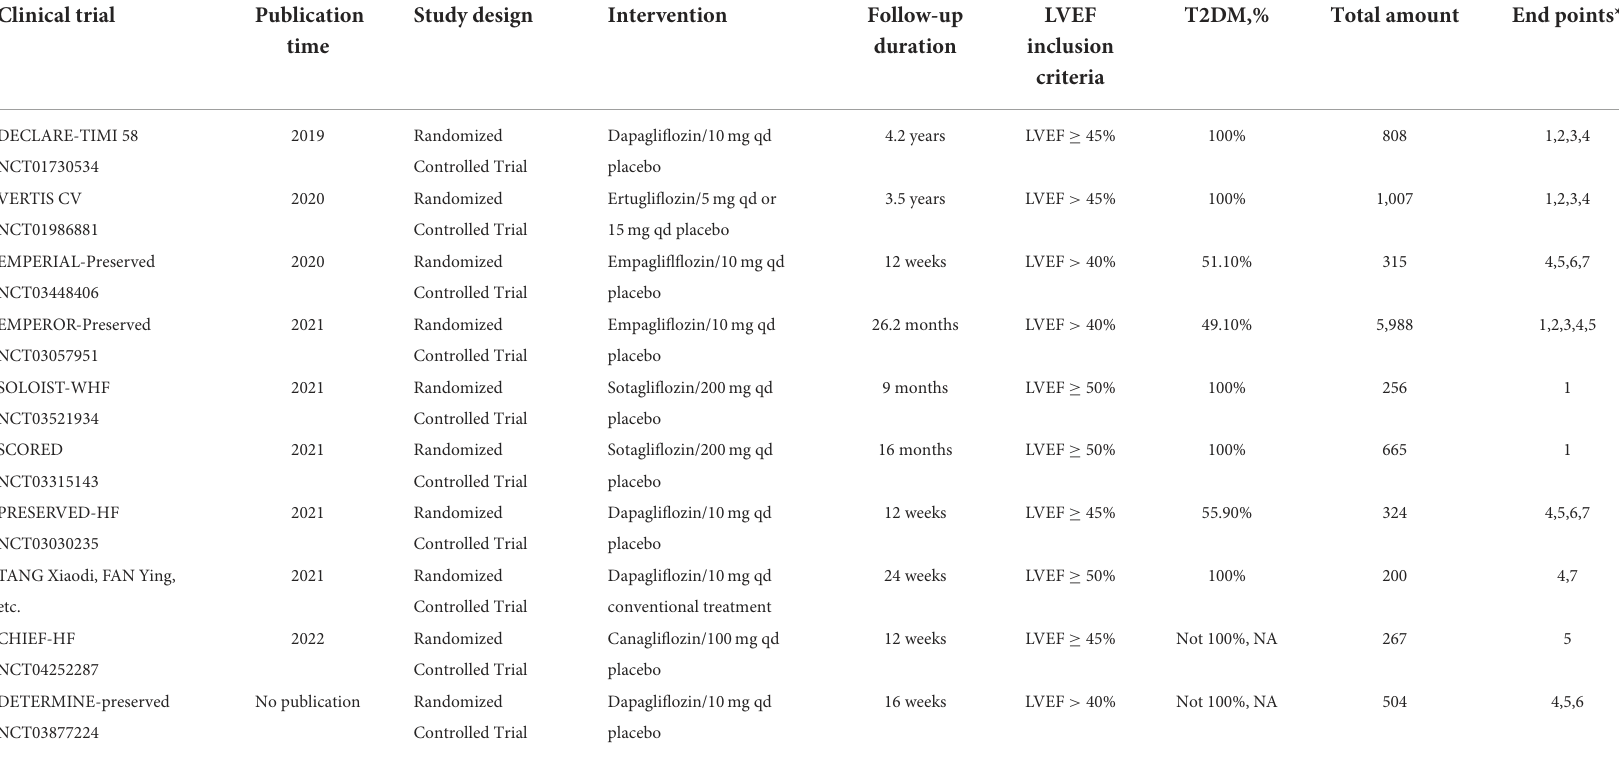
TABLE 1A Basal characteristics of included